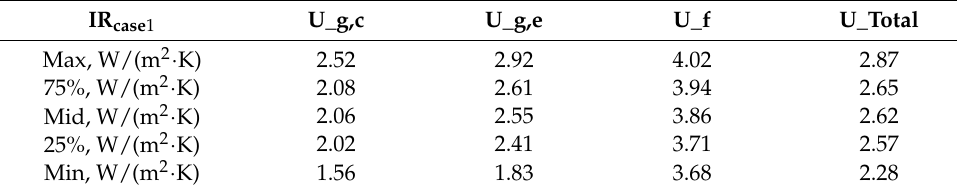
Table 7. Window U-values using the IR case1 method. 𝐈𝐑 𝐜𝐚𝐬𝐞𝟏 U_g,c